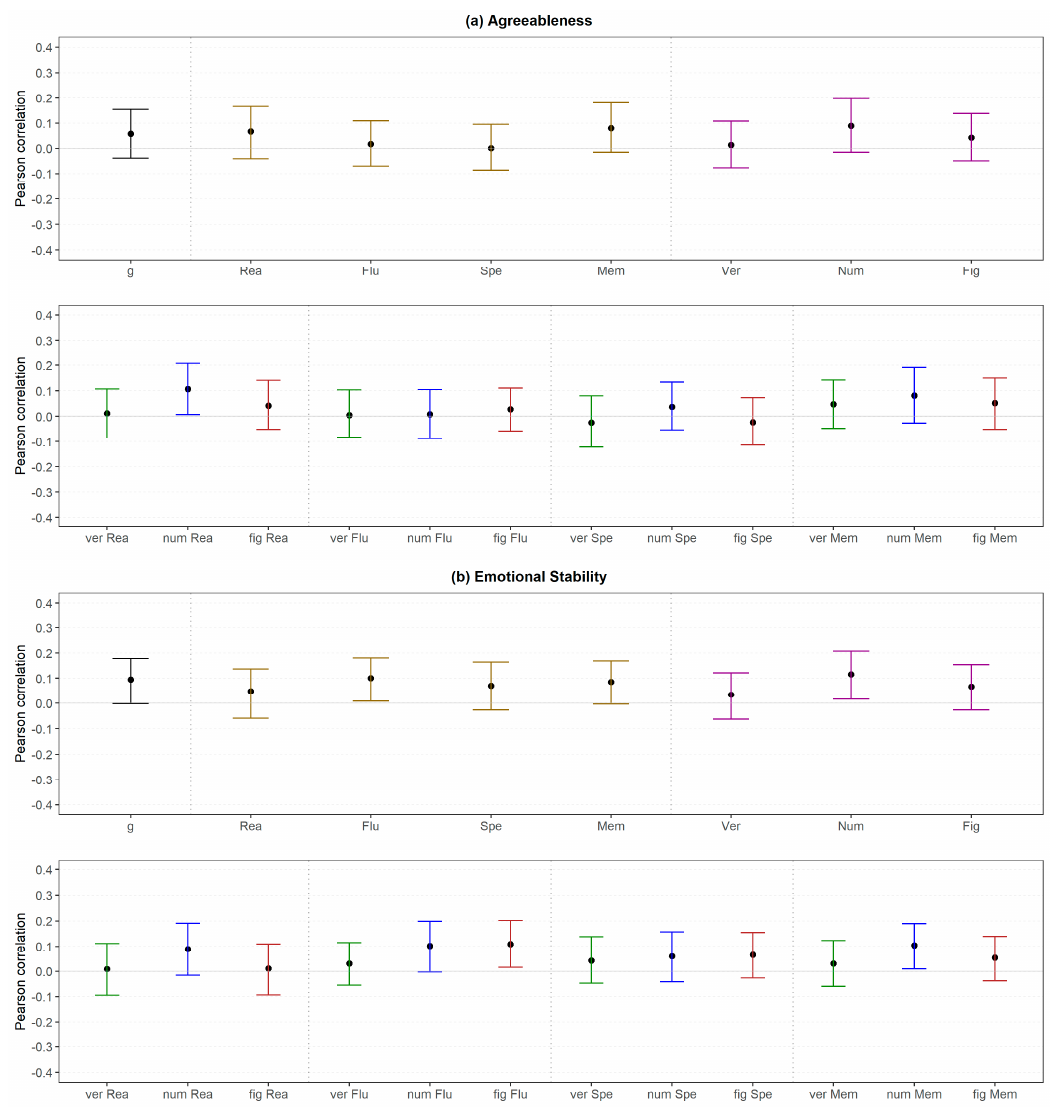
Figure 12. Study 2: Correlations between intelligence and ( a ) Agreeableness and ( b ) Emotional Stability. Rea = reasoning, Flu = fluency, Spe = perceptual speed, Mem = memory, Ver = verbal (intelligence), Num = numerical (intelligence), Fig = figural (intelligence).